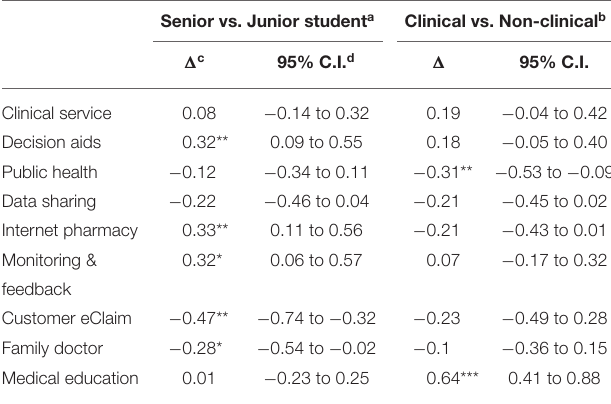
TABLE 6 | Importance rank of mean BWS scores stratified by study years and study